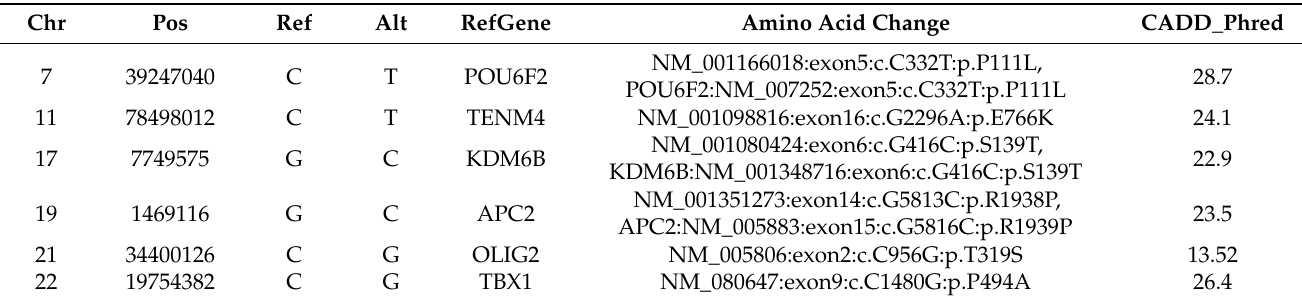
Table 1. Members of the gene ontology (GO) term “cell fate